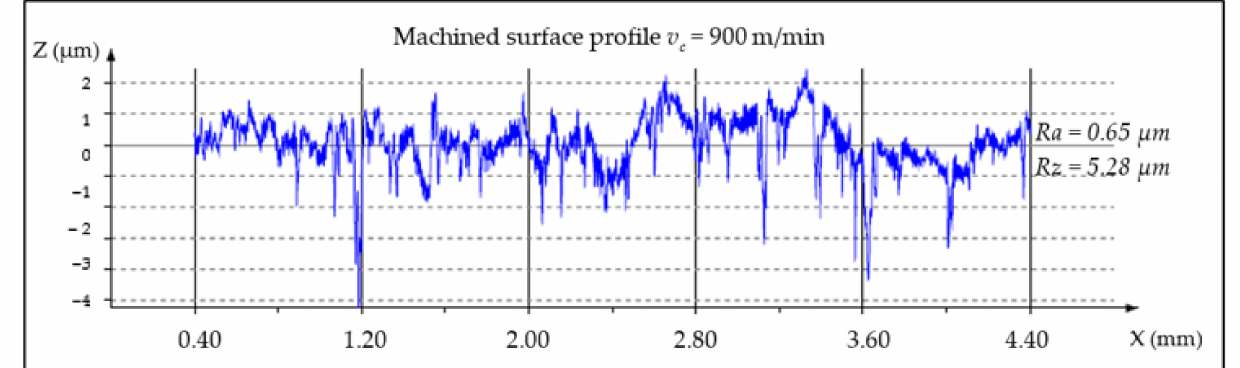
Figure 4. Machined surface profile of the AA359/SiC/10p, v c = 500 m/min, t c = 1.82 min.